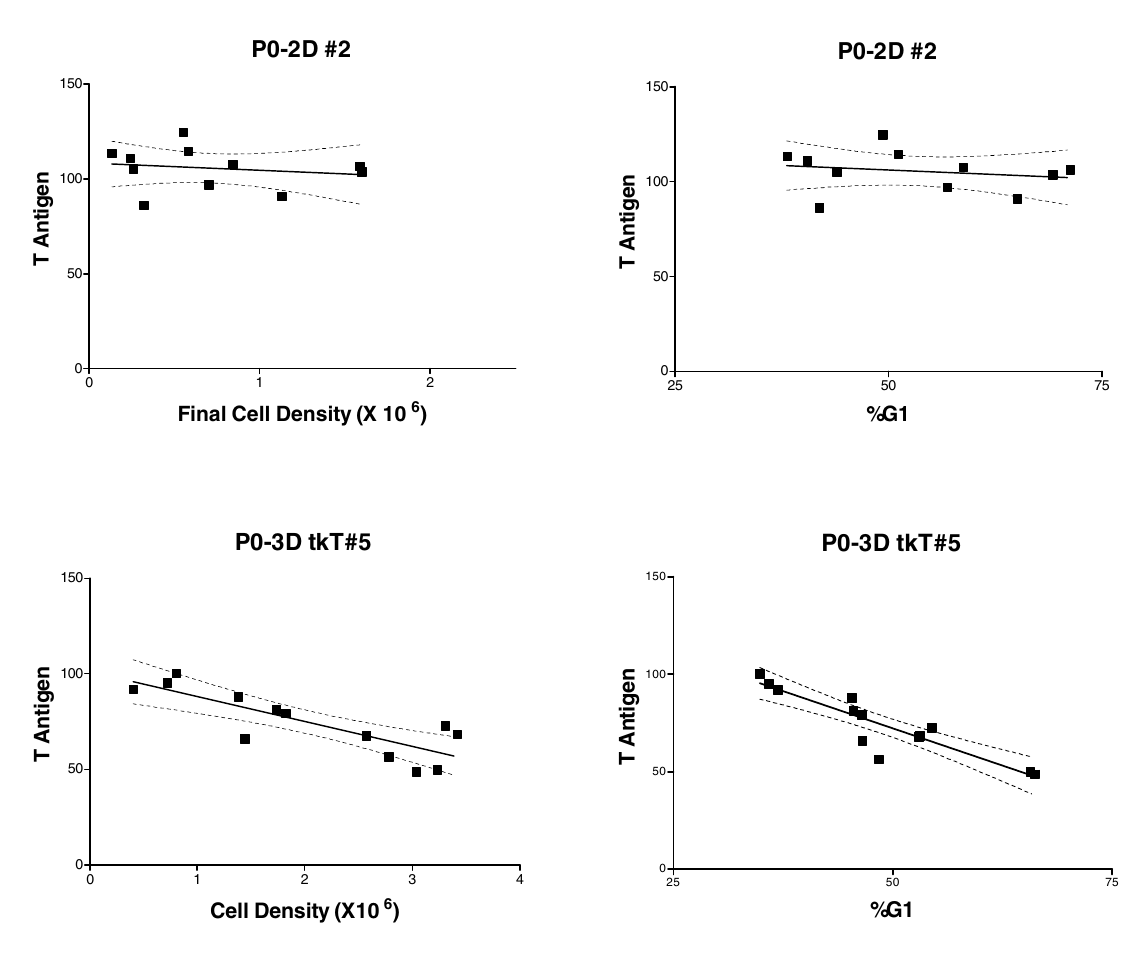
Figure 6 Exponential growth related Tag expression. The density and %G 1 related expression profiles are show for a cell line that does not show a significant density related change (top) and one that does (bottom). P0-2D#2 expresses Tag from the retrovi- ral LTR and P0-3DtkT#5 expresses Tag from the htk promoter. Dashed lines represent the 95% confidence interval about the regression line.